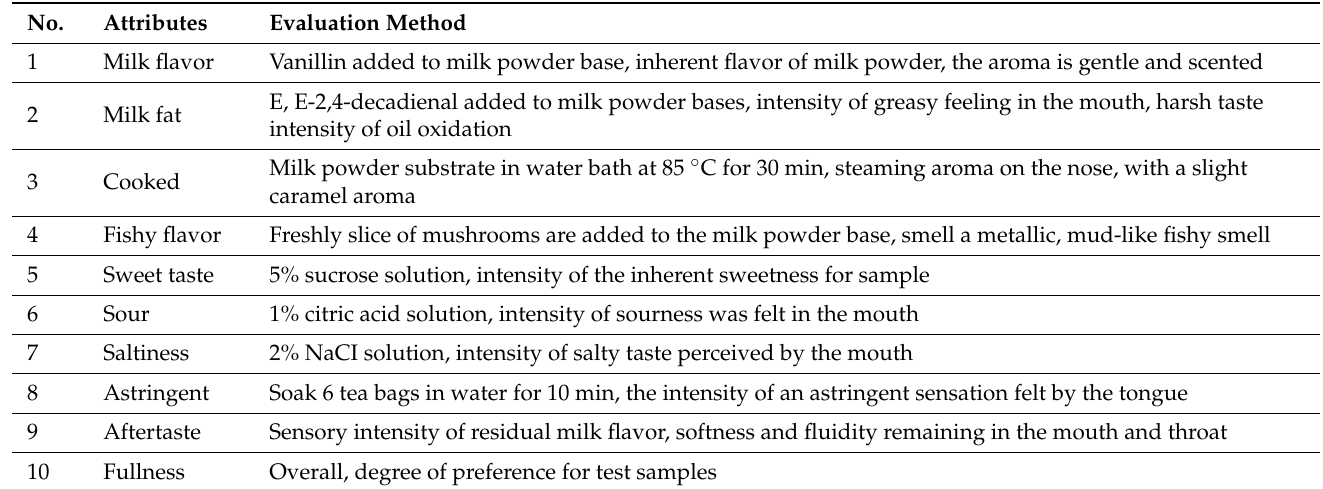
Table 2. Sensory attributes and standard of sensory evaluation